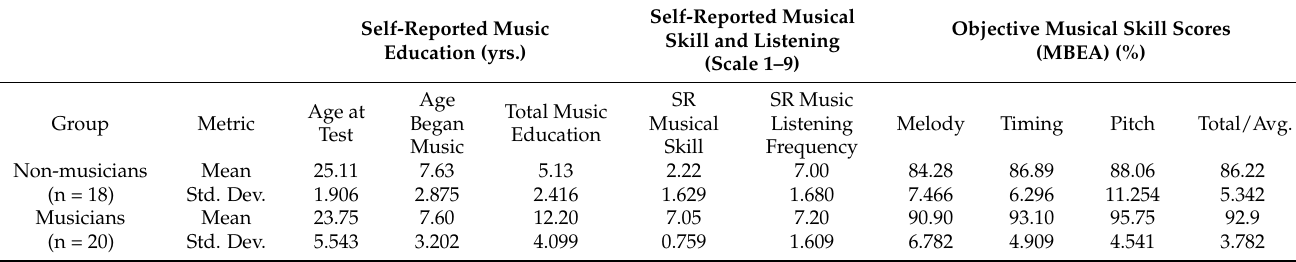
Table 1. Group characteristics of music education, experience and skill in non-musicians and musicians. Self-Reported Musical Self-Reported Music Objective Musical Skill Scores Skill and Listening Education (yrs.) (MBEA) (Scale 1–9)